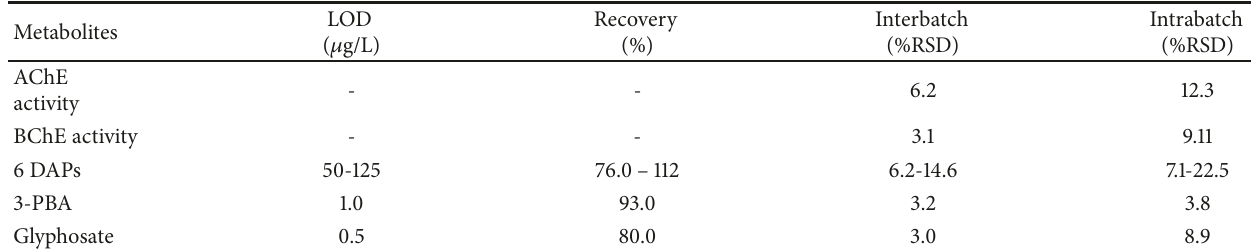
Table 1: Quantification of methods for detecting biomarkers of pesticide exposure.